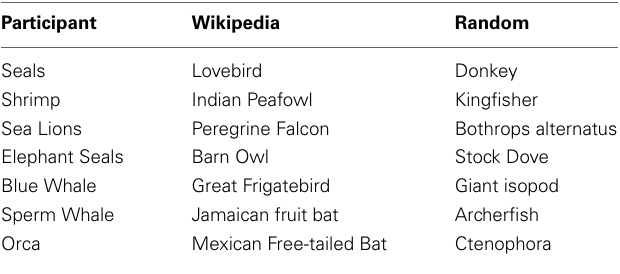
Table 1 | Example series of animals recalled by a participant and network walker model runs over Wikipedia animal network and scrambled control network.